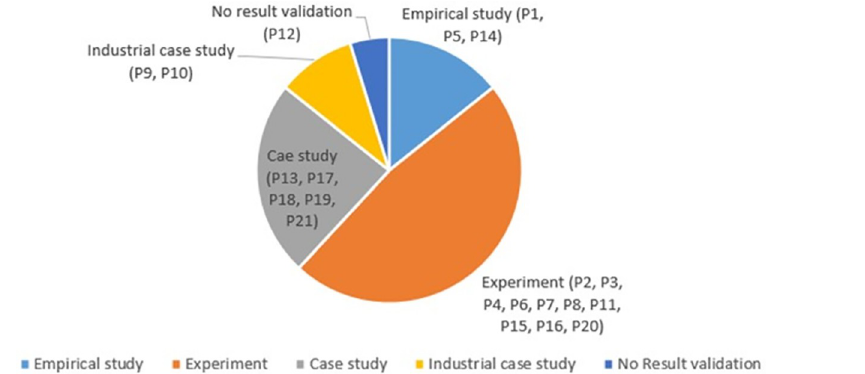
Fig 5. Distribution of studies according to results validation method